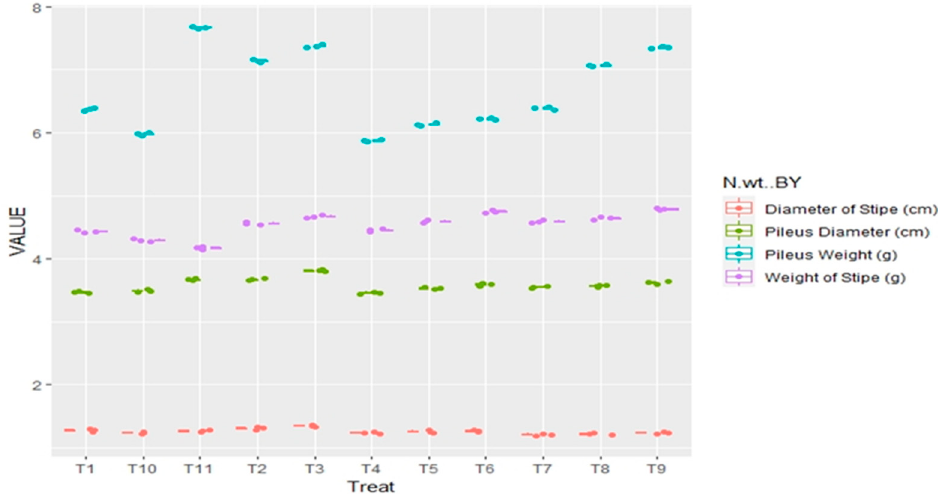
Figure 6. Boxplots for impact of non-systemic fungicides on T. harzianum infested casing pooled during spring 2017 and 2018 on quality parameters of A. bisporus, where T1 = Prochloraz manganese 0.05% conc., T10 = Check I(infested-untreated), T11 = Check II(uninfested-untreated), T2 = Prochloraz manganese 0.1% conc., T3 = Prochloraz manganese 0.2% conc., T4 = Chlorothalonil 0.05% conc., T5 = Chlorothalonil 0.1% conc., T6 = Chlorothalonil 0.2% conc., T7 = Captan 0.05% conc., T8 = Captan 0.1% conc., T9 = Captan 0.2%